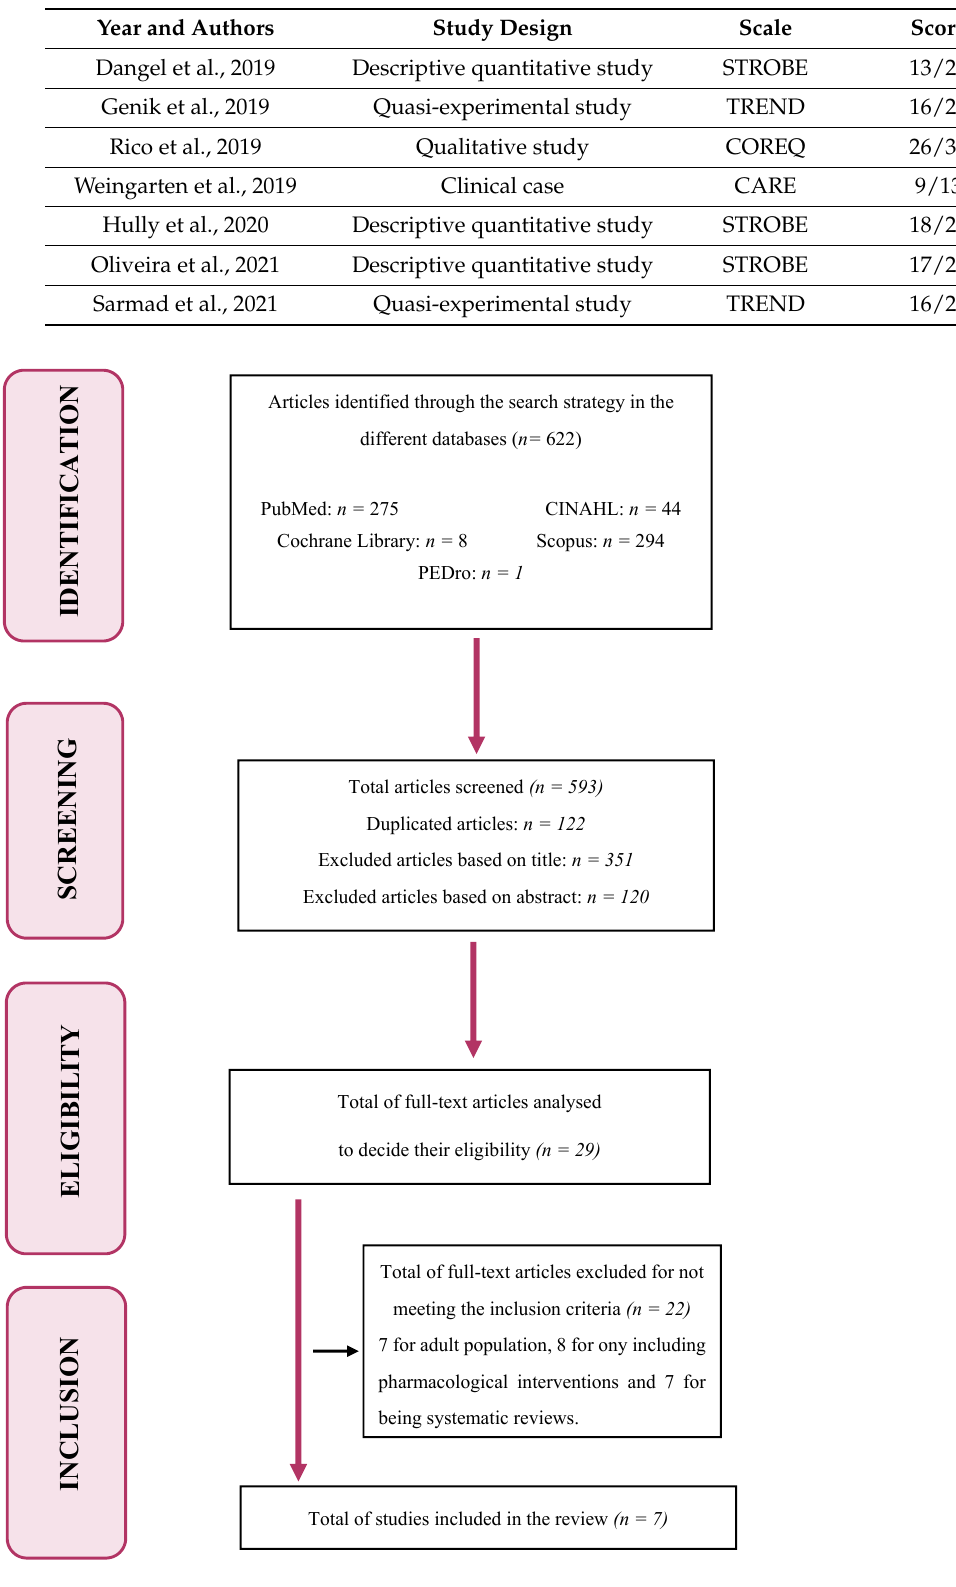
Figure 1. Flowchart of the article selection